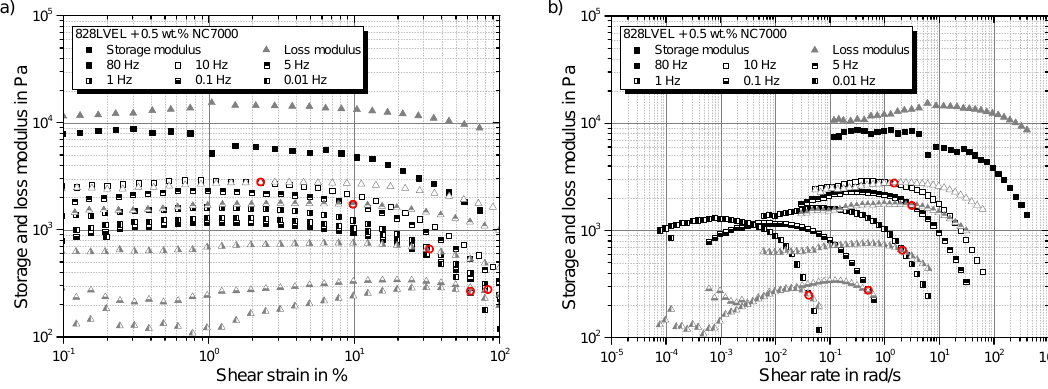
Figure 7. Dependency of storage and loss modulus on ( a ) shear strain and ( b ) shear